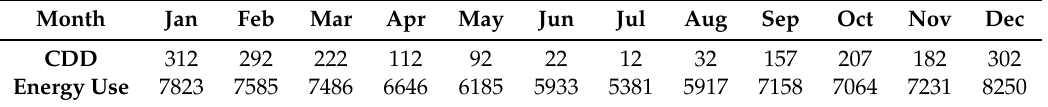
Table 1. Cooling Degree Day (CDD) Data for International Performance Measurement and Verification